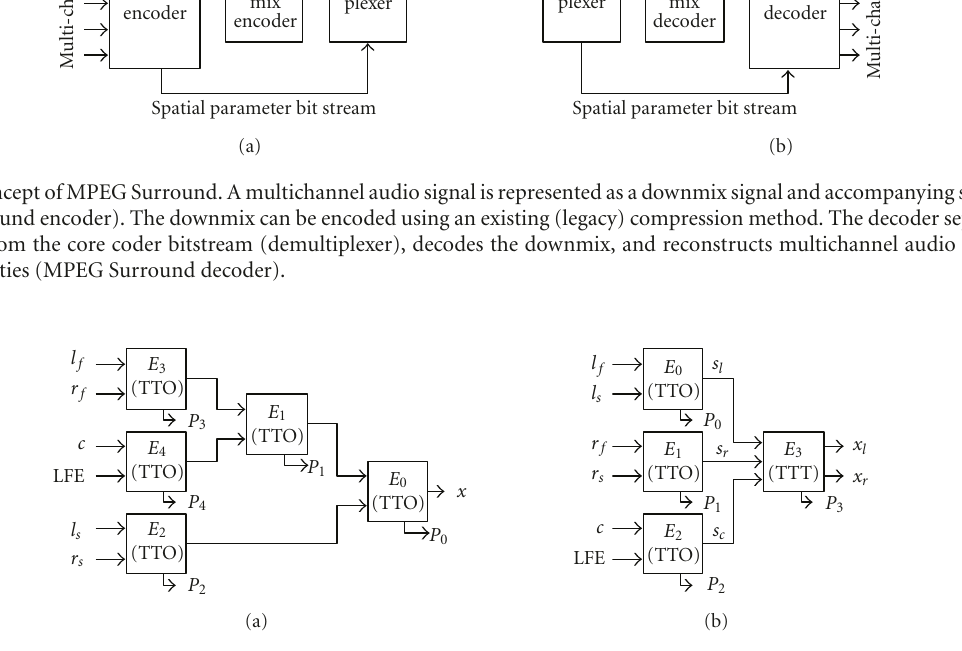
of shoulders and the pinnae) are more important